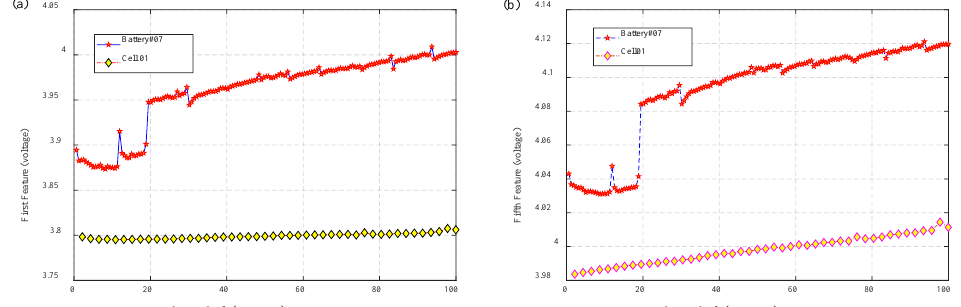
Figure 5. Comparison of ( a ) first and ( b ) fifth feature. The first feature refers to the voltage value at 1/3 of the battery during each charge, and the fifth feature is the voltage at 5/9. This means that although the battery data sets are different, the charging voltage has a similar distribution during the charging process of the battery.